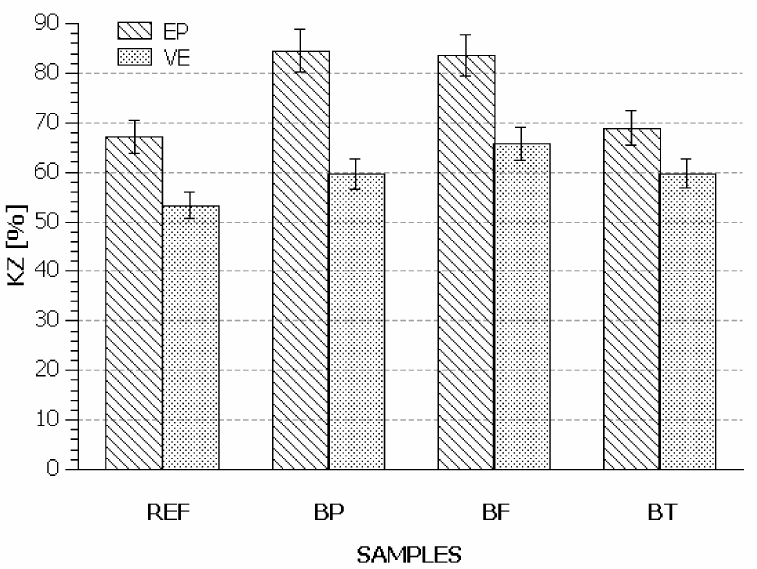
Figure 15. Relative toughness KZ of composite materials at 25 ◦